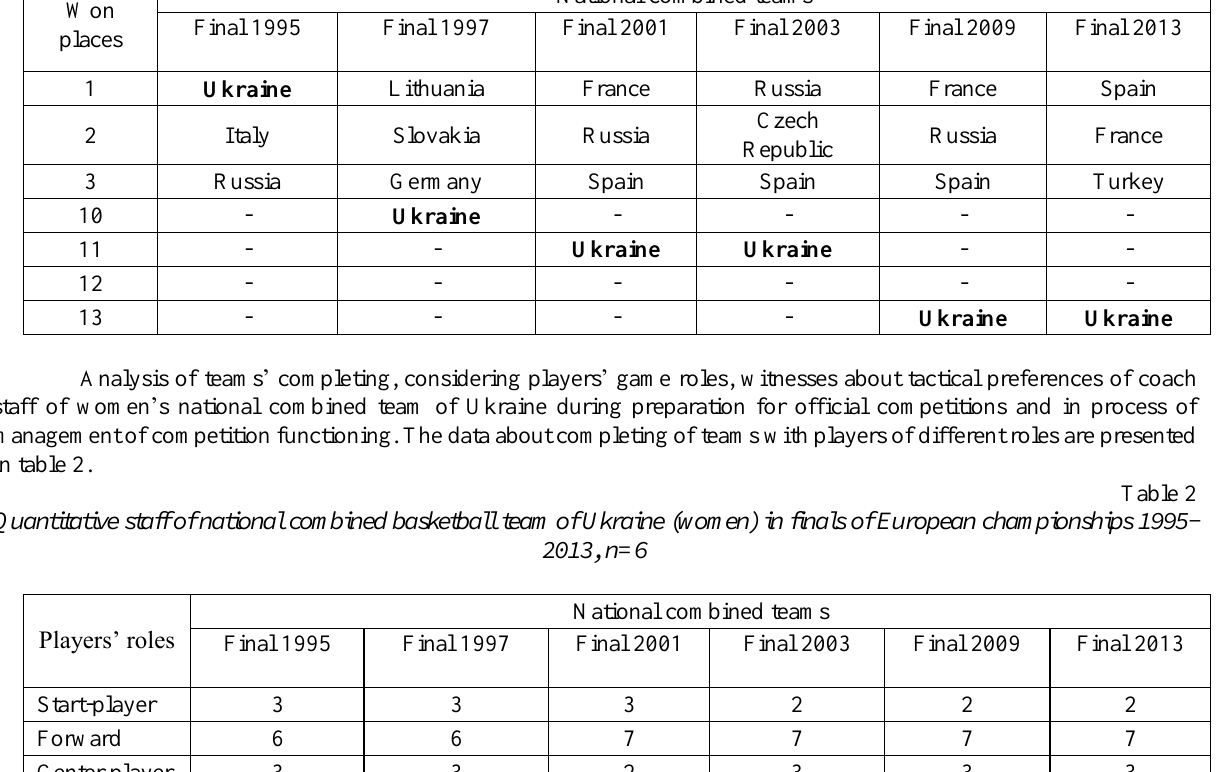
Pedagogic analysis of table 3 witnesses that the most effective was team staff at European championship 1995: 3-start players, and attacking backs; 6 – “light” and “heavy” forwards, 3 – center players. Correlation of won and lost games witnesses about general level of sport fitness of women’s national basketball combined team of Ukraine in finals of European championships 1995-2013. The received results are given in table 3. “Victory-defeat” indicators of national basketball combined team of Ukraine (women) in finals of